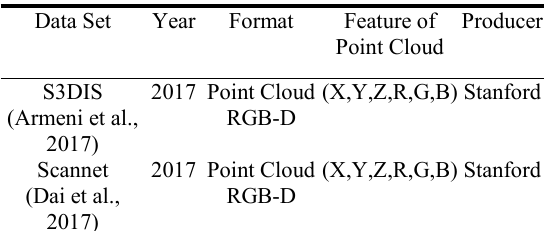
Table 1. Current open large indoor point cloud datasets